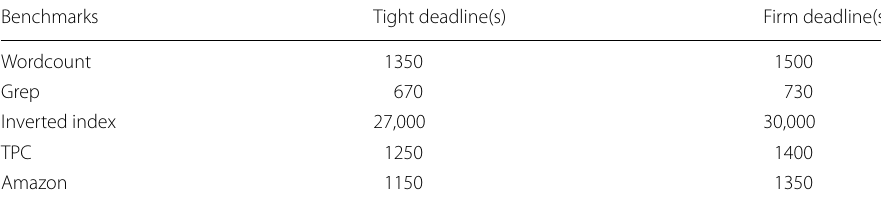
Fig. 12 Sensitivity analysis to data variety (z Table 3 Tight and Firm Deadline for benchmarks